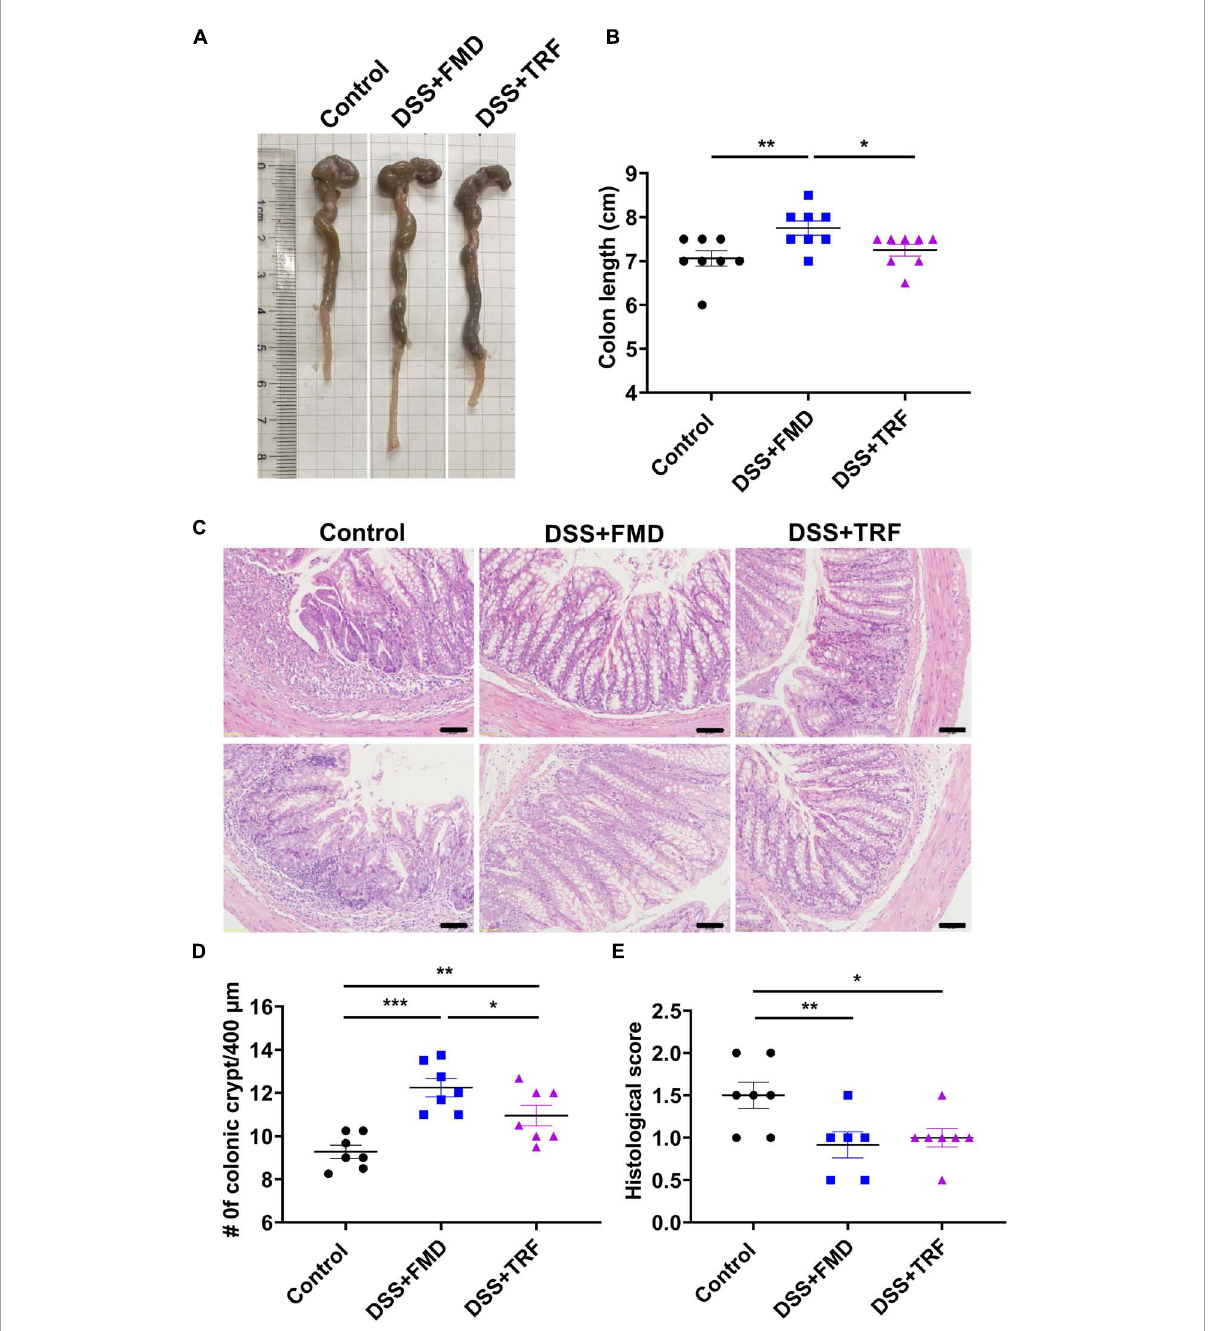
FIGURE2 TRF increases the number of crypts and reduce the histological score in the colon. (A) Representative images of the colon at the end of the experiment. (B) The length of colon of the mice ( n = 8 for each group). (C) Histology of colon tissue examined by HE staining. The images were taken at 20 X magnification. Scale bars: 50 µ m. (D) Changes of colonic crypts number of the mice ( n = 7 for each group). (E) Histological scores of colon tissues based on HE staining ( n = 6 to 7 for each group). Data are presented as mean ± SEM; * P < 0.05, ** P < 0.01, *** P < 0.001.